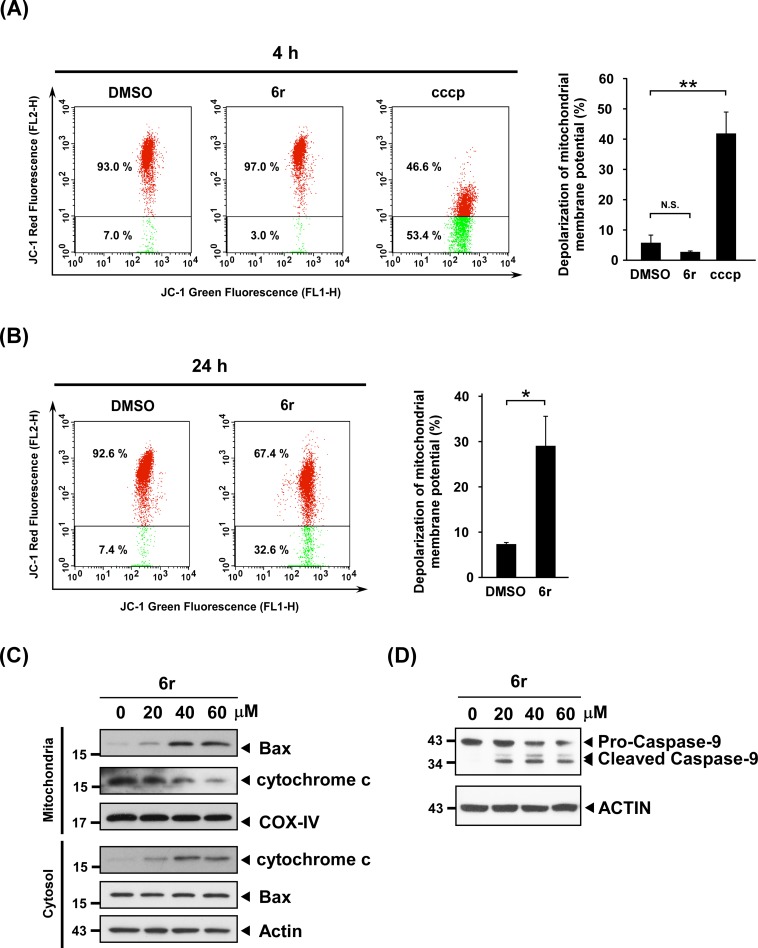
CTSS inhibition by 6r causes mitochondrial damage.(A) The mitochondrial membrane potential was determined using JC-1, and was quantified using flow cytometry. Cells were treated with 20 μM of 6r for 4 h, and then stained with JC-1 for 30 min. The JC-1 aggregated form exhibited red fluorescence, indicating high membrane potential, whereas the JC-1 monomer form exhibited green fluorescence, indicating the collapse of membrane potential. CCCP was used as a positive control. Differences were found to be statistically significant at **P < 0.01. N.S. denotes no significant difference. (B) The inhibition of CTSS by 6r for 24 h induced the collapse of the mitochondrial membrane potential. Differences were found to be statistically significant at *P < 0.05. (C) Cells were exposed to 6r at the indicated concentrations for 24 h. Mitochondrial and cytosolic fractions were prepared as described in the materials and methods section, and were subjected to western blot analysis for cytochrome c, Bax, ACTIN, and COX-IV. ACTIN and COX-4 were used as the internal control for cytosolic and mitochondrial fractions, respectively. (D) Cells were treated with 6r for the indicated concentrations, and cleaved caspase-9 fragments were analyzed with western blotting. ACTIN was shown as an internal control for semiquantitative loading in each lane.